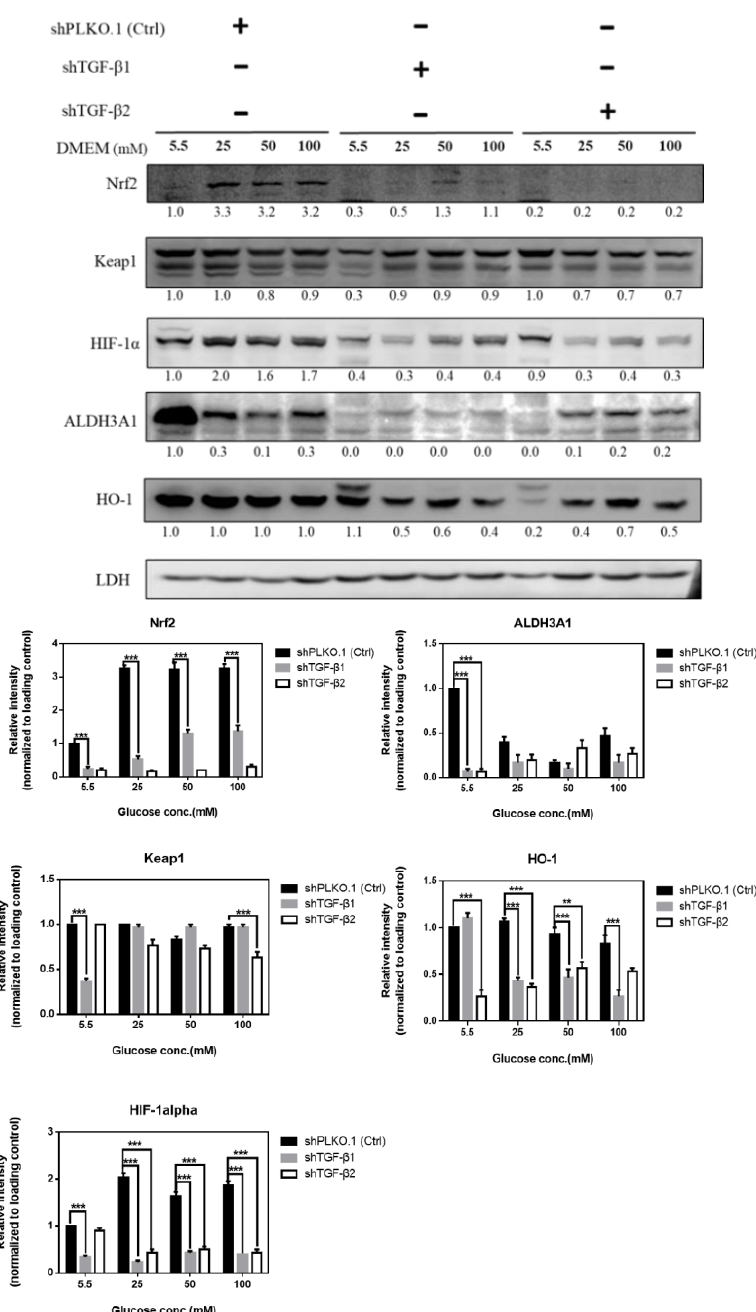
Figure 5. Immunoblot analysis of activation of downstream substrates in TGF- β 1 / 2 knockdown RGC-5 cells with hyperglycemia. Immunoblot analysis of antioxidation pathway-associated proteins (Nrf2, Keap1, HIF-1 α , ALDH3A1, and HO-1) in 5.5 mM, 25 mM, 50 mM, and 100 mM glucose supplemented medium. The protein expression values were quantified in relation to the loading control. Data are represented as means ± SEM. **, p < 0.01; ***, p < 0.001; ns, non-significant, when compared to the 5.5 mM group ( n = 3).